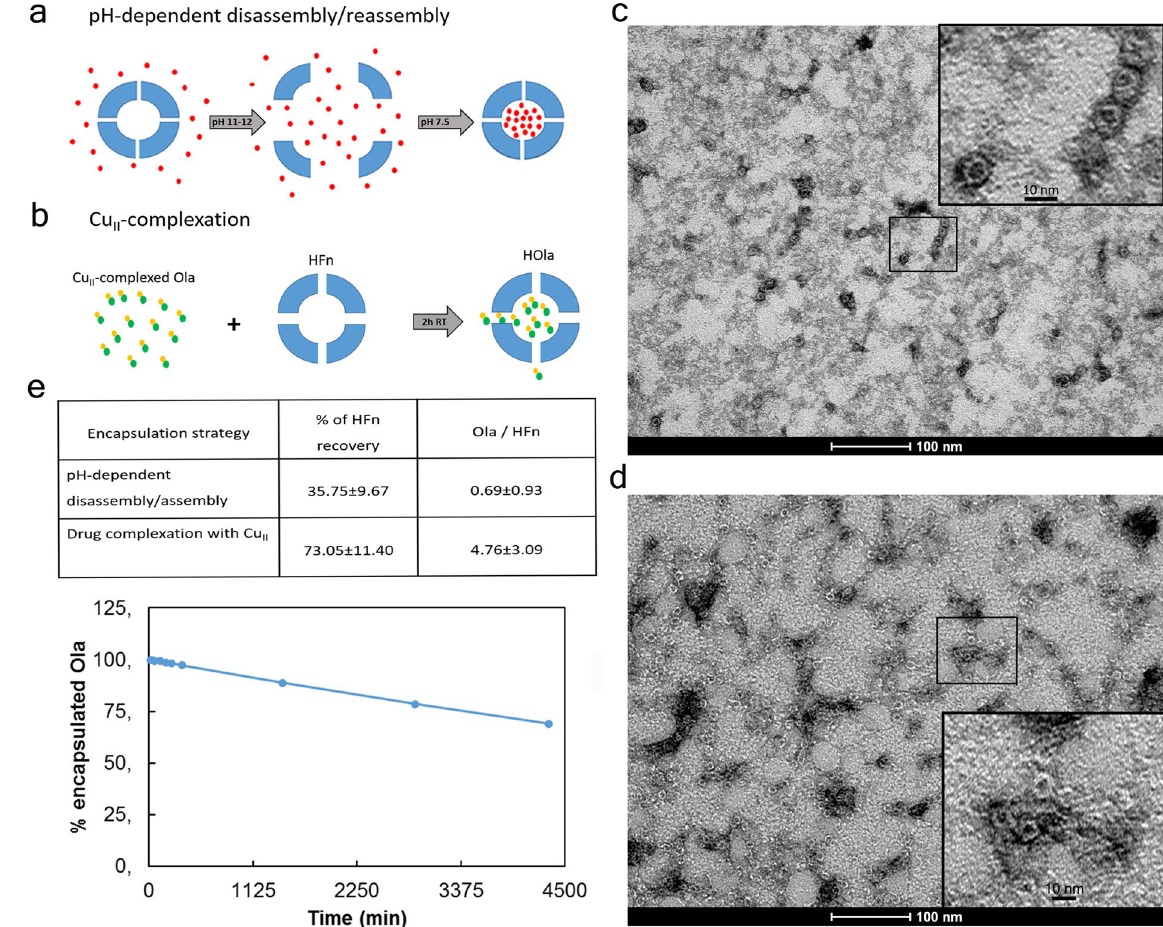
Figure 3. Development and characterization of HOla. ( a ) Schematic representation of the pH-dependent disassembly/reassembly method used for HFn loading with Olaparib. Olaparib is represented in red. ( b ) Schematic representation of the HFn loading strategy through Olaparib pre-complexation with Cu(II). Olaparib is represented in green, while Cu(II) in yellow. ( c ) Electron microscopy images of Olaparib-loaded HFn nanoparticles obtained with the pH-dependent disassembly/reassembly strategy or ( d ) with the Cu(II) pre-complexation. ( e ) Summary of yields of HFn encapsulation with Olaparib. ( f ) Drug release from HOla nanoparticles. The kinetic of Ola release from HFn nanocages was determined by HPLC-MS quantifying the amount of Ola released in the dialysis medium. The nanodrug is highly stable at 37 °C in PBS buffer. The release from HFn nanocage is less than 3% even after 6 h